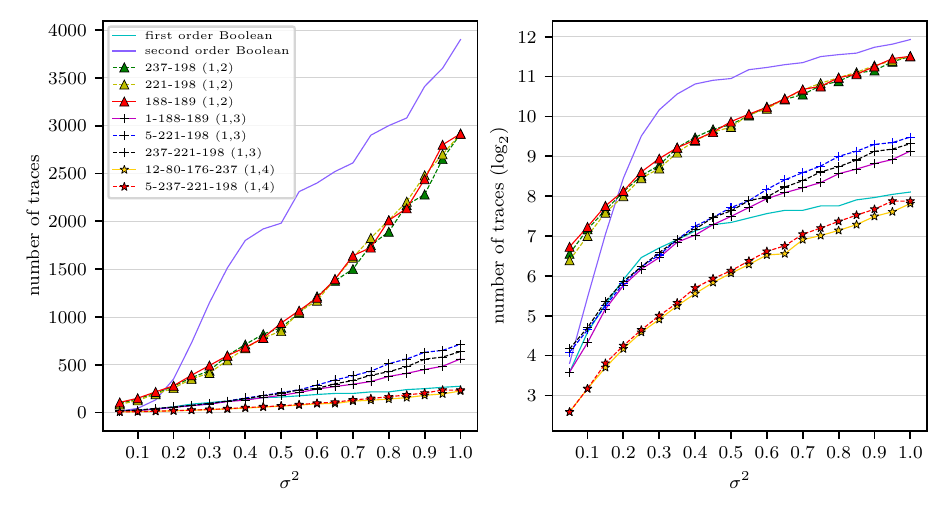
Figure 3: Attacks on (1 , n ) masking scheme with sets of interpolation points stable under the Frobenius automorphism for 0 . 05 ≤ σ 2 ≤ 1 . 0 and comparison with Boolean masking and “normal” sets of interpolation